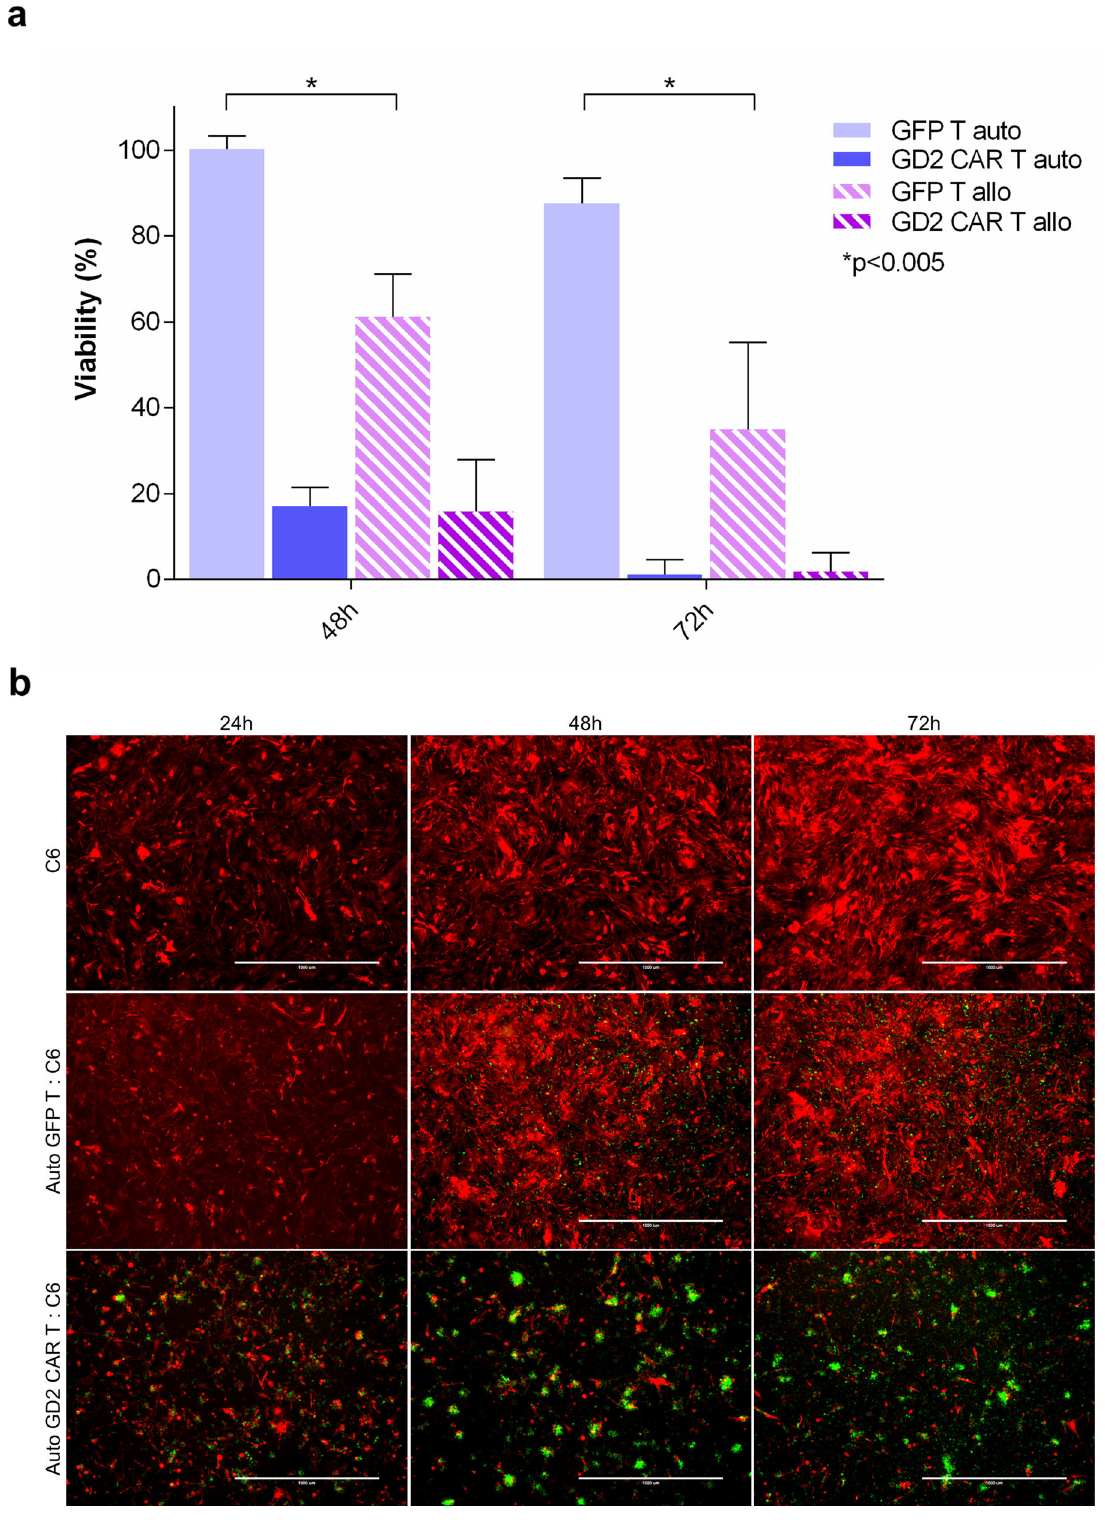
Fig. 4 Autologous GD2 CAR T cells kill glioblastoma in vitro. a Glioblastoma cells (dsRED C6) co-cultures with either autologous or allogeneic GD2 CAR T and GFP control T cells at 5:1 E:T ratios. After 48 and 72 h tumor viability is calculated by fl uorescence assay as reported in “ Methods ” . Data are shown as mean ± SD from three technical replicates; p values are calculated by unpaired two-tailed t -test. b Representative fl uorescence micrographs show clusters of activation and killing activity of GD2 CAR T cells. GFP T cell population show an absence of reactivity of autologous cytotoxic lymphocytes. DsRED C6 glioblastoma (red) cells in co-culture with GD2 CAR T (green) and GFP T control cells (green) at 5:1 E:T ratio at 24, 48, and 72 h. The scale bar: 1000